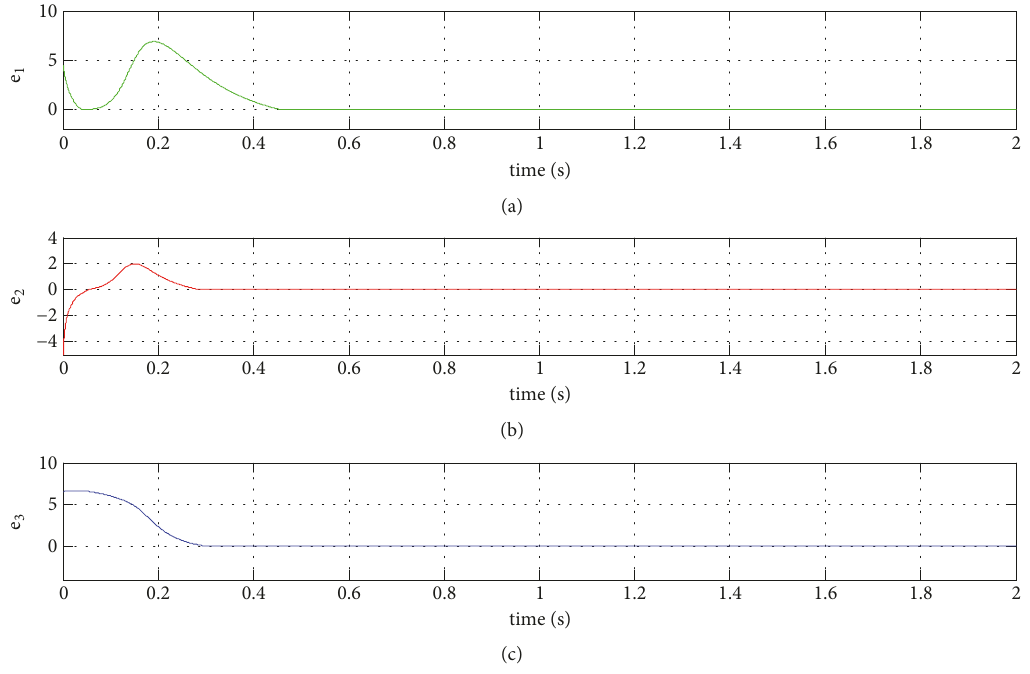
Figure 12: Time evolution of synchronization error signals: (a) 𝑒 1 , (b) 𝑒 2 , and (c) 𝑒 3 .